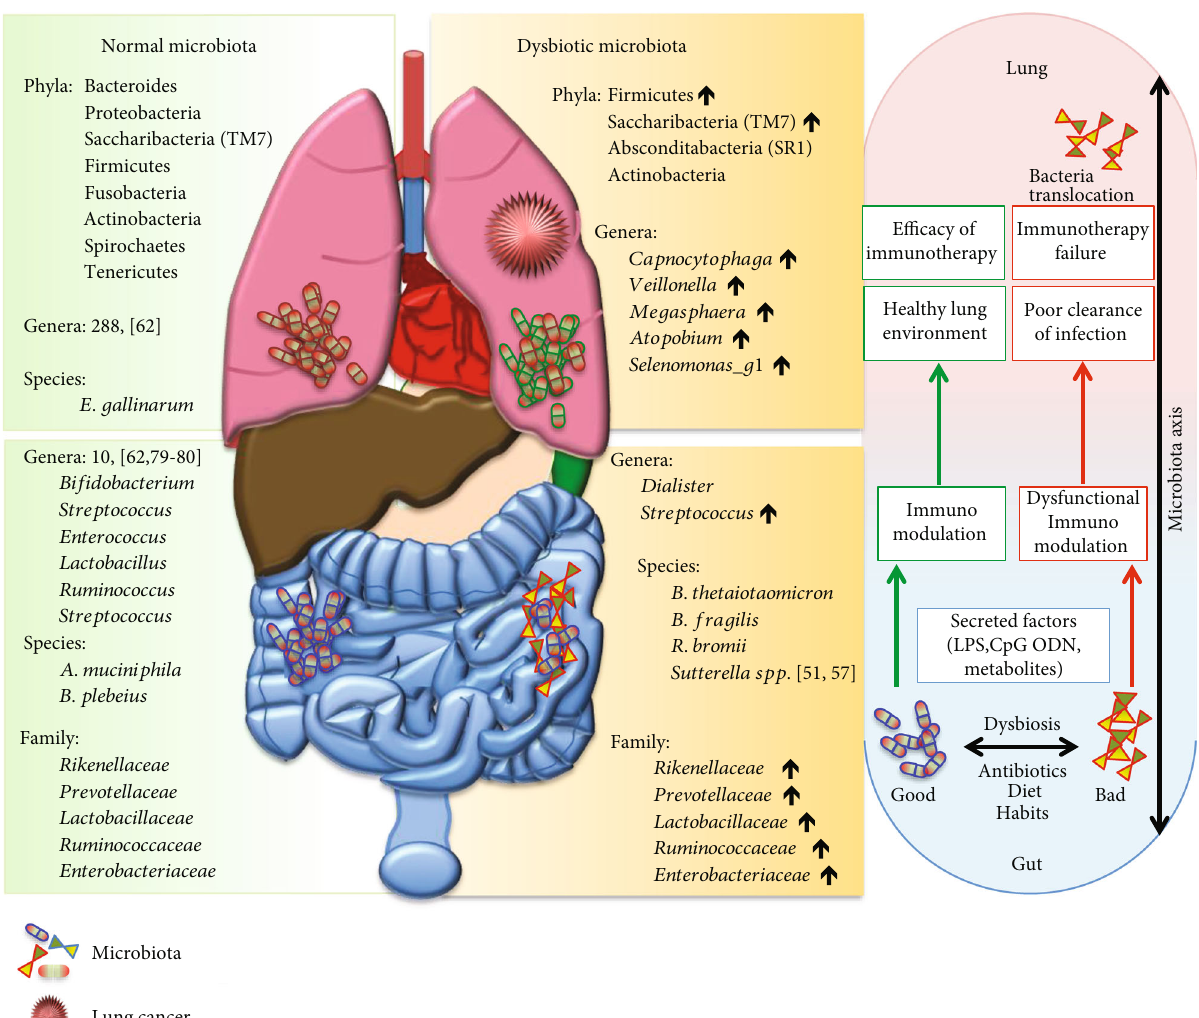
Figure 1: Increasing evidence supports the idea of a dynamic in fl uence between host and microbiota. The fi ne line between human health and disease can be driven by friend (green) or foe (red) microbiota. We reported the main bacteria that could be responsible for the transition from a health to a pathological status. Commensal microorganisms are required for the maturation, education, and function of the immune system. A tight and continuous interaction of immune cells with microorganisms allows learning the di ff erence between commensal and pathogenic bacteria that could in fl uence immunotherapeutic